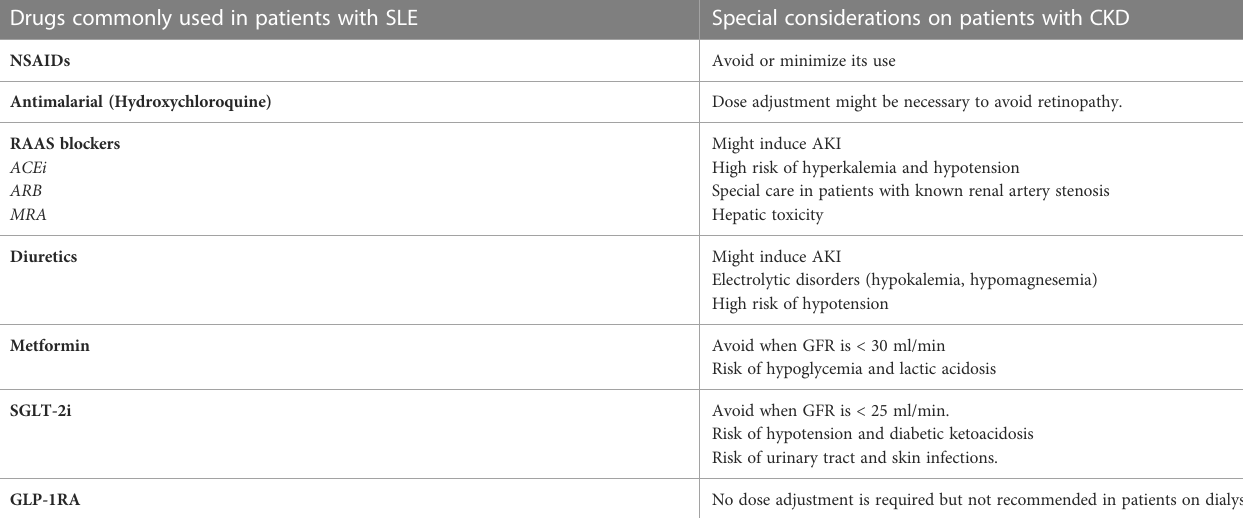
TABLE 1 Commonly used drugs for nephro and cardioprotection in patients with lupus nephritis. Drugs commonly used in patients with SLE